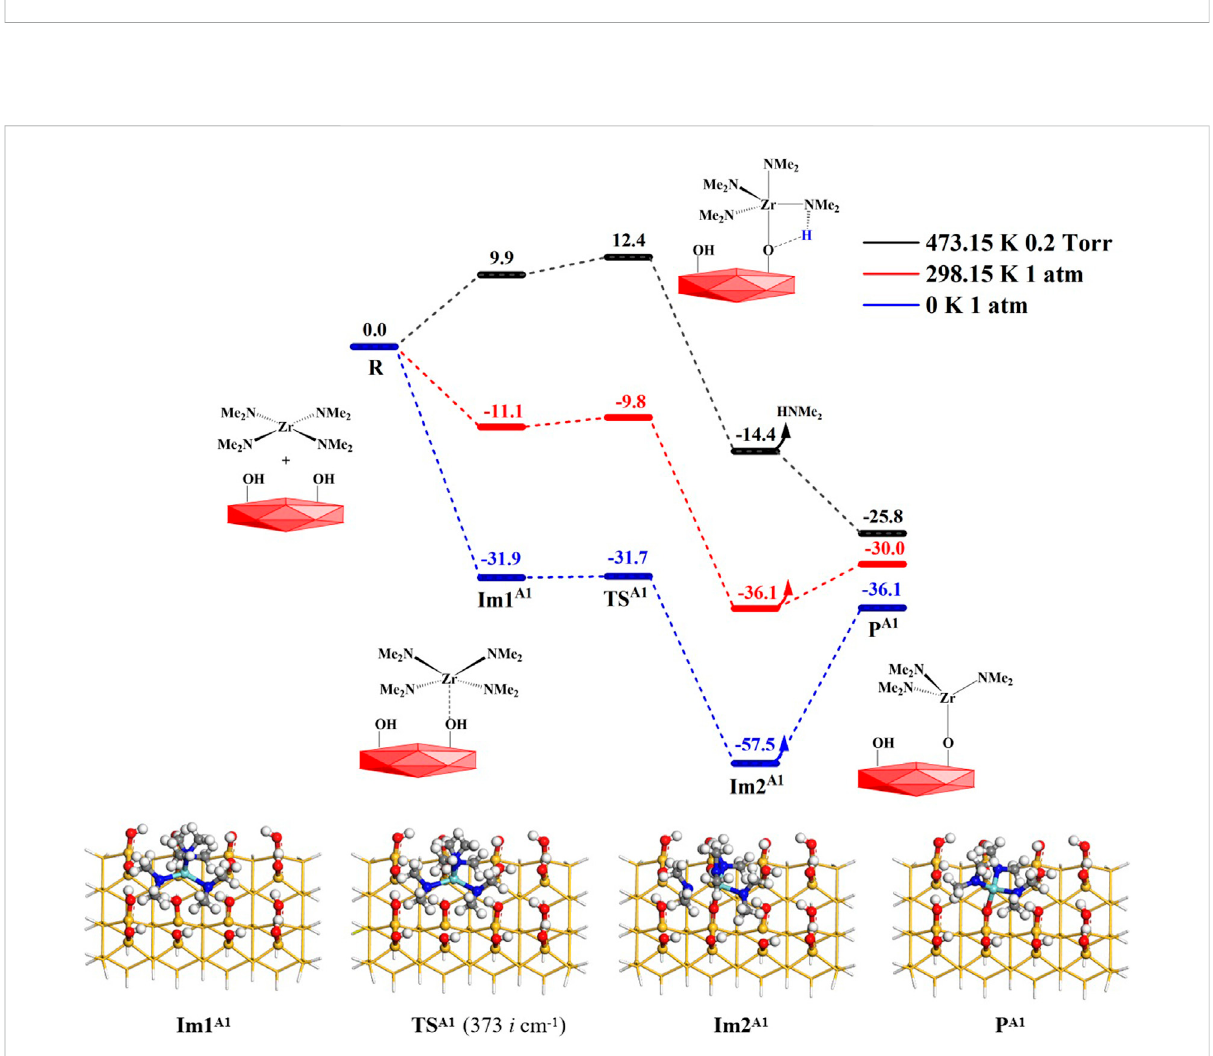
FIGURE 3 Gibbs free energy pro fi les ( Δ G , kcal/mol) of the A1 section of the TDMAZ reaction on the hydroxylated surface.